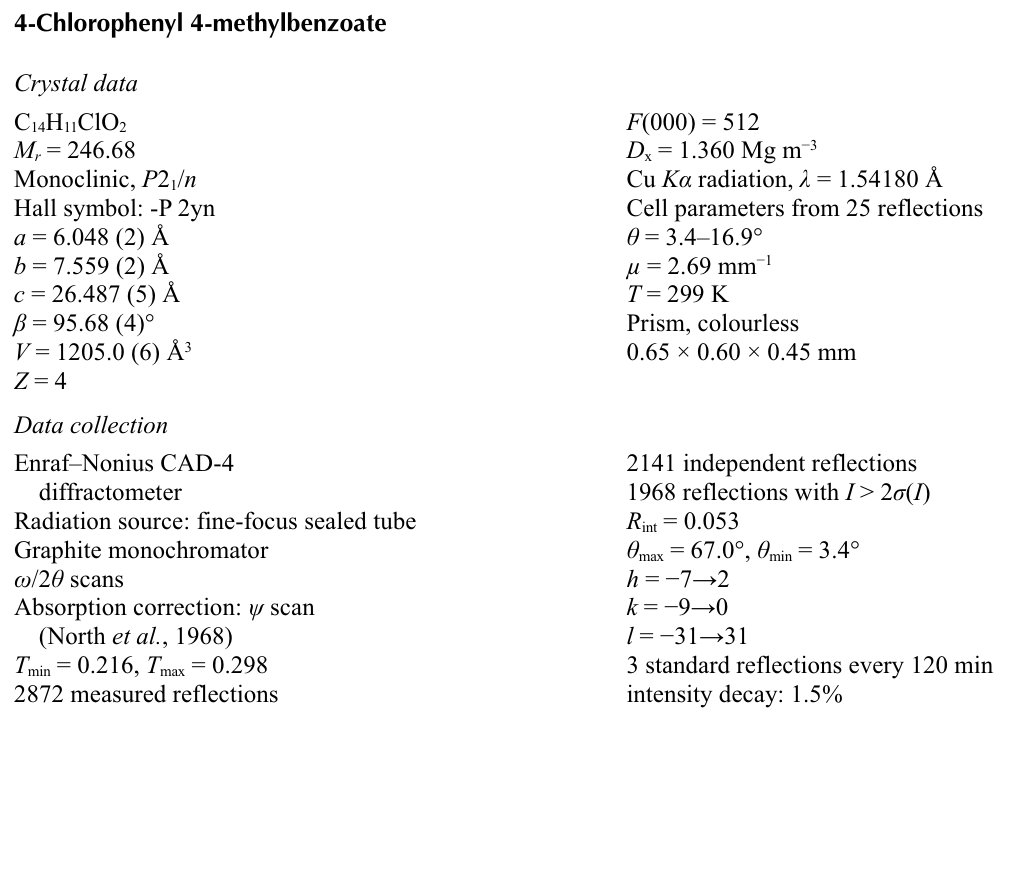
Molecular packing of the title compound, viewed along the b axis. 4-Chlorophenyl